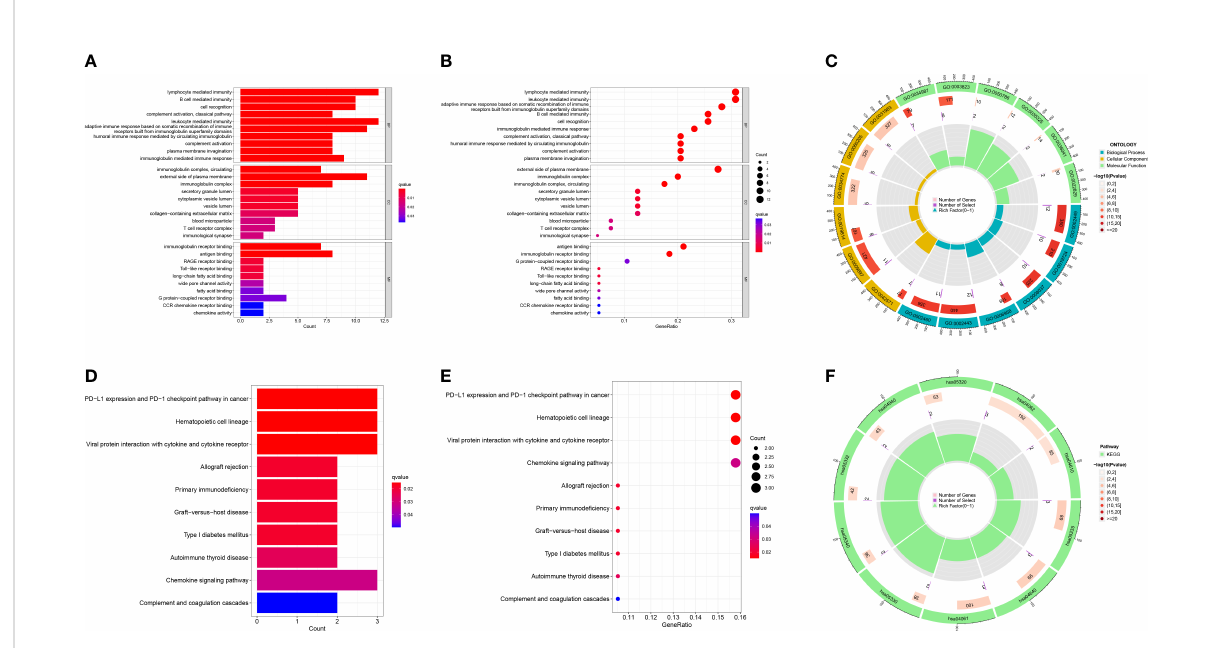
FIGURE 8 GO and KEGG functional analysis. (A – C) The GO enrichment analysis performed utilizing the differently expressed genes between the two risk groups. (D – F) The KEGG enrichment analysis performed utilizing the differently expressed genes between the two risk groups. We found